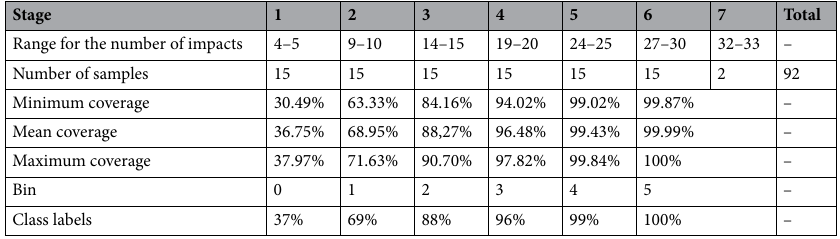
Table 1. Dataset obtained from the FE code 28 , class labels assigned by coverage percentage.